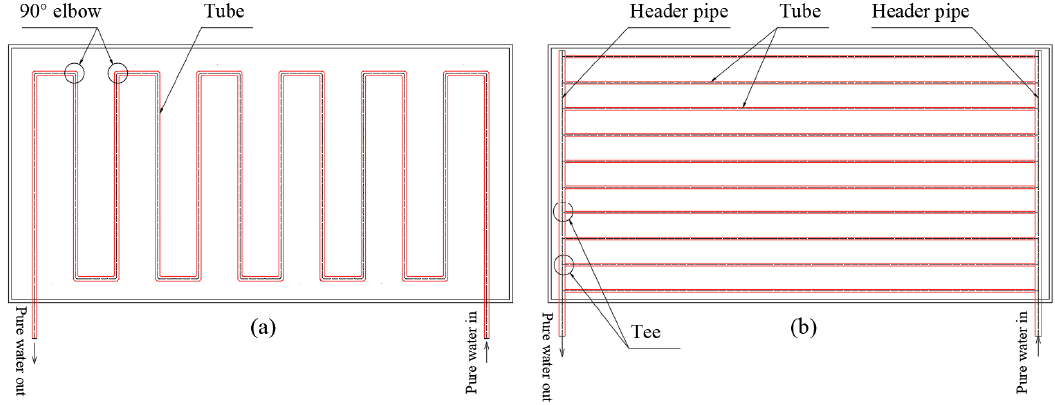
Figure 3. Layout diagram of pipe type CT ( a ) and type PT ( b ). The PV layer is depicted in Figure 4 with components: two layers of EVA glue, PV cells chain and protective layer.